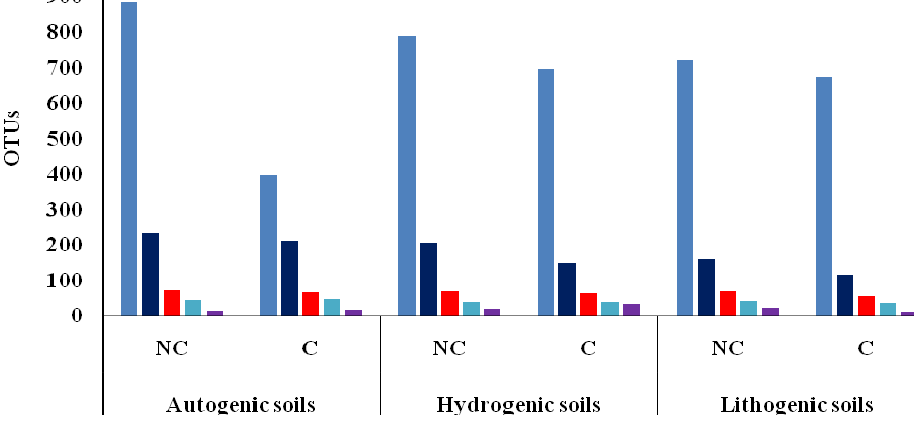
Figure 2. Relative abundance of bacteria at the phylum level across all soil samples (NC– non-cultivated soil; C–cultivated soil) classified according to its formation processes (autogenic, hydrogenic, and